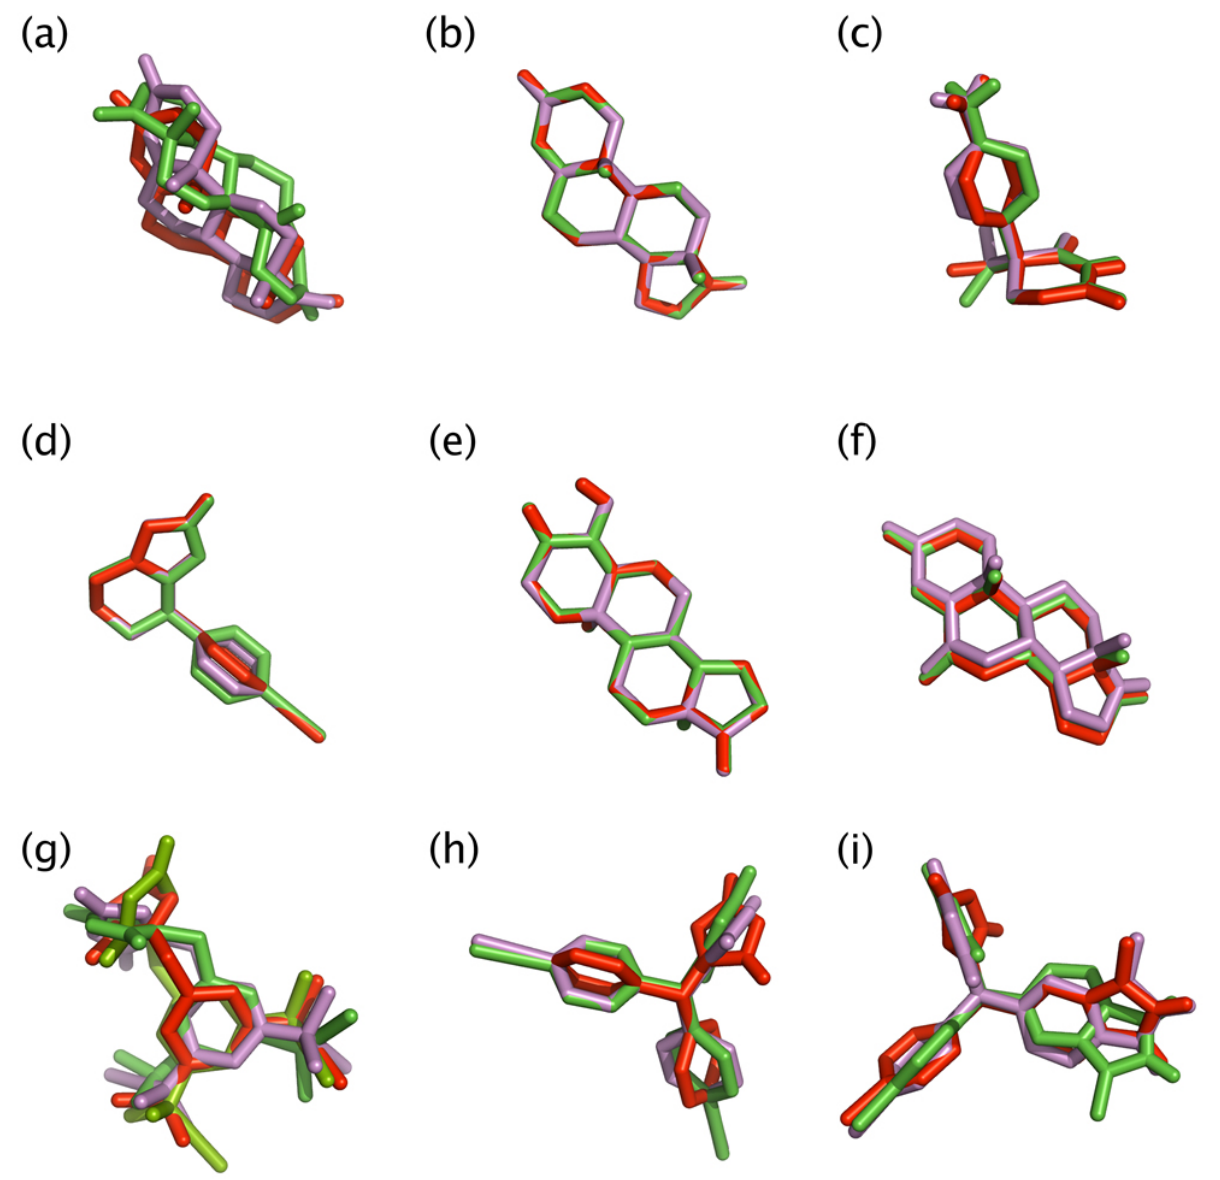
Figure 5. Superimposition of crystallized structure of androstenedione (shown as red sticks), docked conformer of aromatase at 0 ns of MD simulation (shown as purple sticks) and docked conformer of aromatase at 100 ns of MD simulation (shown as green sticks) poses of androstenedione (a) for validating docking protocol. Structure superimposition of (b) androstenedione, (c) aminoglutethimide, (d) fadrozole, (e) formestane, (f) exemestane, (g) anastrozole, (h) letrozole and (i) vorozole for elucidating the effect of MD